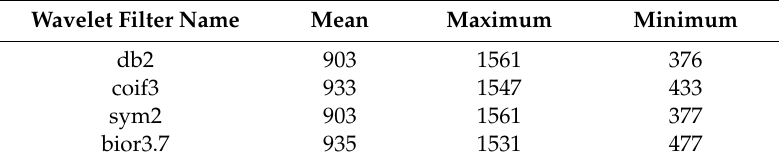
Table 1. Daily mean, daily maximum, and daily minimum of 15-min average planetary boundary layer heights (m) from 10:00 to 18:00